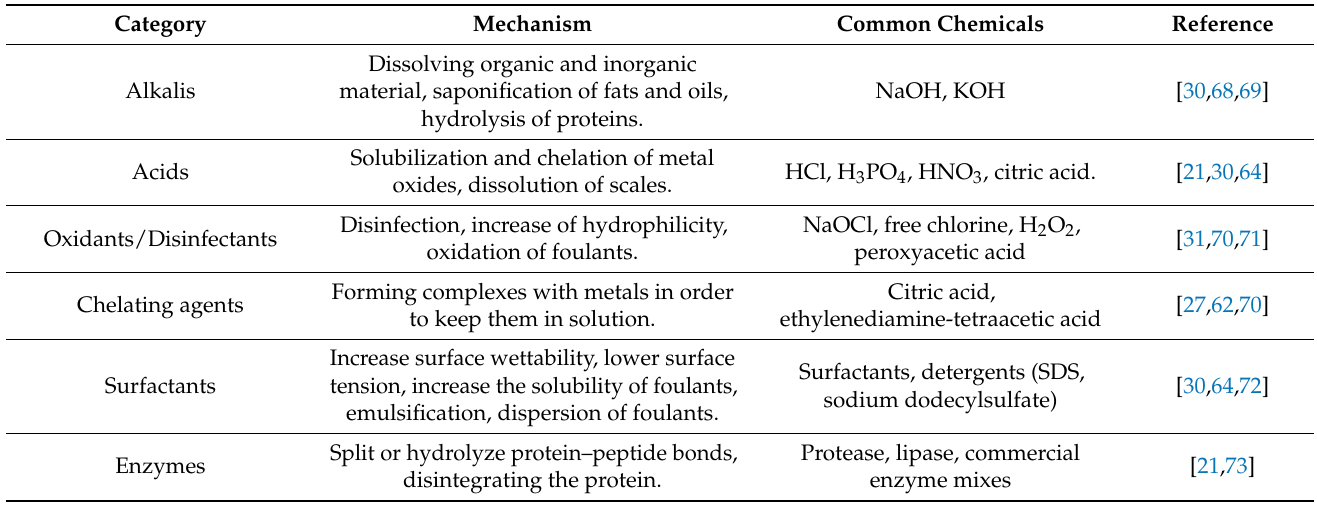
Table 2. Chemical membrane cleaning reagents and their cleaning